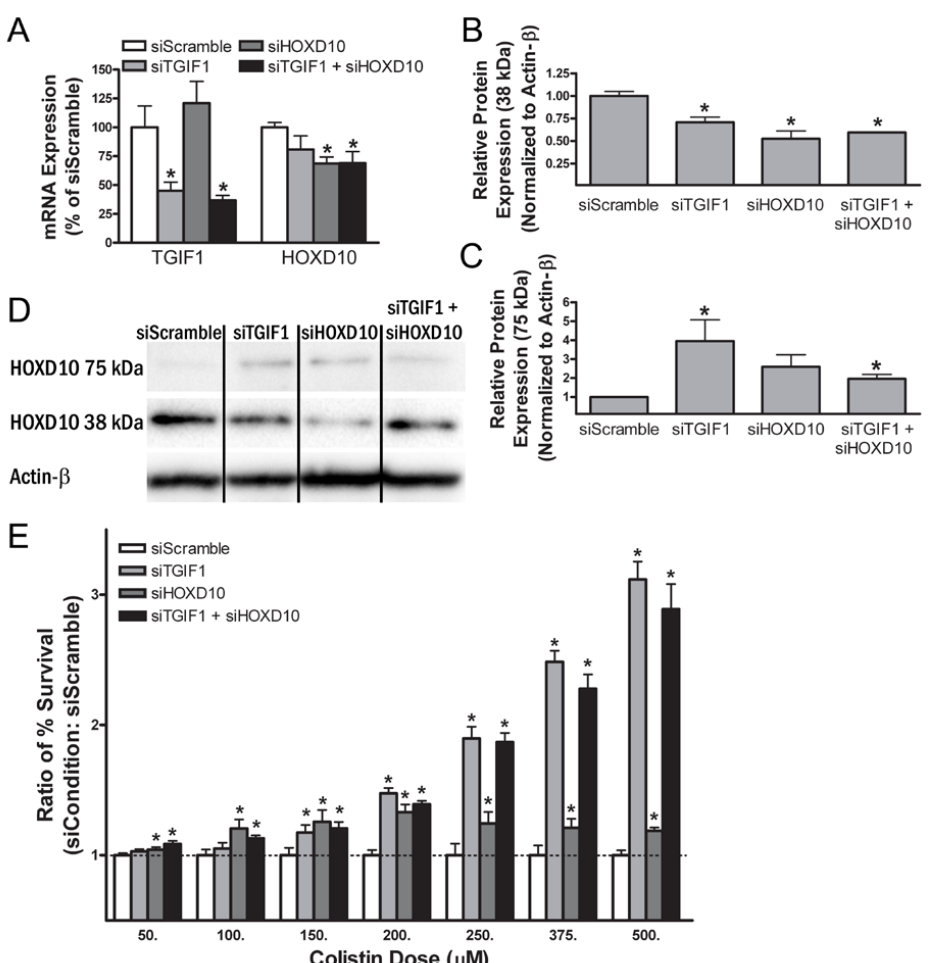
Figure 6. Effect of gene knockdown on gene expression, protein expression, and cellular resistance to colistin. Following transfection with small interfering RNA (siRNA), the effect on gene expression ( A ); protein expression of HOXD10 ( B – D ); and colistin-induced cytotoxicity ( E ) was determined for a control scramble siRNA (siScramble or siRNA targeting TGIF1, HOXD10, and the combination of both. Knockdown was performed with at least three biological replicates (six or more technical replicates). mRNA levels were measured by real-time quantitative polymerase chain reaction (qRT-PCR) 24 h post-siRNA transfection. Gene expression is given as a percentage of expression relative to siScramble after Glyceraldehyde 3-phosphate dehydrogenase (GAPDH) normalization. Protein expression was calculated from densitometry with an Actin- β control and then compared to siScramble. Cytotoxicity was measured 24 h after initial colistin exposure. Cell survival at each concentration was calculated relative to control (no drug). The relative increase in % cell survival is expressed as a ratio of each condition’s knockdown (siCondition) to the siScramble. * = p ≤ 0.05 by Student’s t -test between the scramble siRNA and the siRNA targeting each gene. Baseline HOXD10 gene expression was low in NHPTK cells, contributing to the modest knockdown